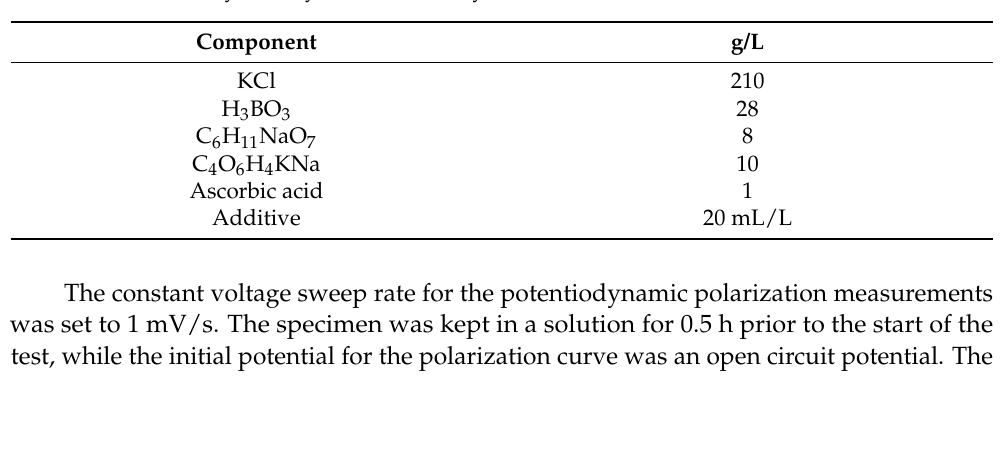
Table 2. Basic electrolyte for cyclic voltammetry